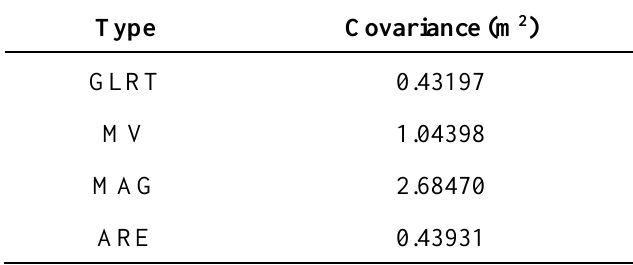
Table 1. Covariance of the four Zero-Velocity Detection (ZDET) models.